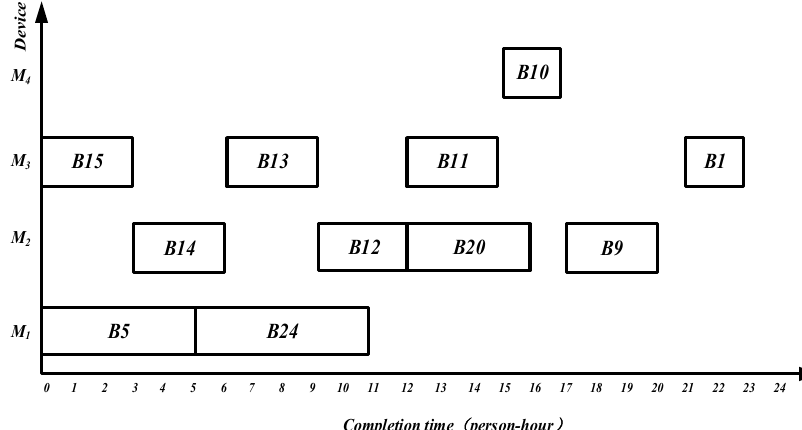
Figure 19. Gantt chart obtained by the ACPM for workshop f 1 with 23 person-hours.